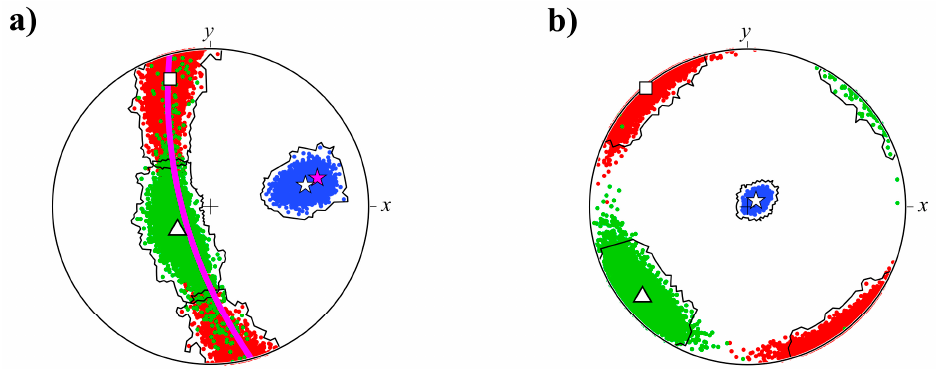
Figure 7. The upper hemisphere stereographic projections of principal axes of the mean inertia tensor of vesicles in Sample_1 ( a ) and Sample_2 ( b ) after non-parametric bootstrapping (see text for details). Directions of the principal axes are colored in the same way as in Figure 6: red— I min , green— I int , blue— I max . White stars denote the orientation of I max principal axis of the mean inertia tensor. Magenta stars and lines denote the direction normal to the plane of dike walls and the plane itself correspondingly. Black lines contour the 95% confidence regions.